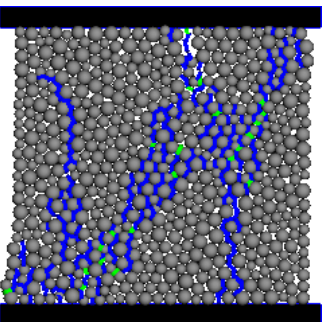
Figure 6. The 2D-PM model calibration: final crack pattern for the uniaxial compression test of the mortar